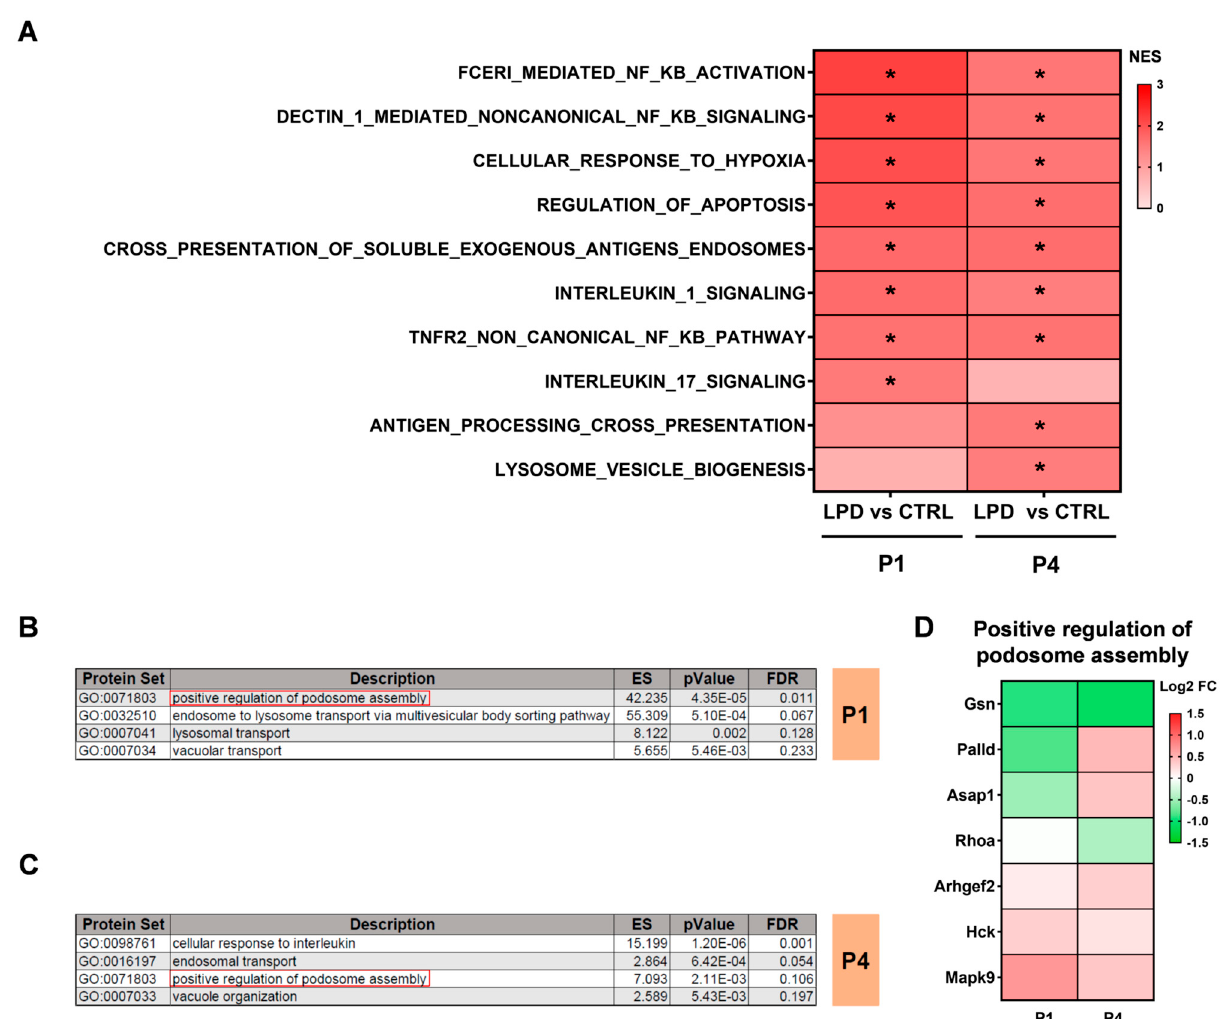
Figure 3. Protein sets associated with inflammation are deregulated in the LPD microglial proteome. ( A ) GSEA analysis performed against the Reactome pathway database. Upregulated protein sets in LPD P1 vs. CTRL P1 and LPD P4 vs. CTRL P4 are reported, * p < 0.05 vs. CTRL. ( B , C ) ORA analysis of differentially expressed proteins between ( B ) CTRL and LPD at P1 and ( C ) CTRL and LPD at P4 performed against the GO database. ( D ) Log2 FC of proteins associated with the positive regulation of podosome assembly. Upregulated proteins are depicted in red and downregulated proteins in green.